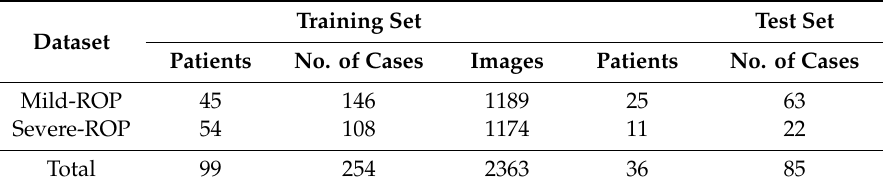
Table 3. Mild-ROP and severe-ROP dataset used for training and testing.